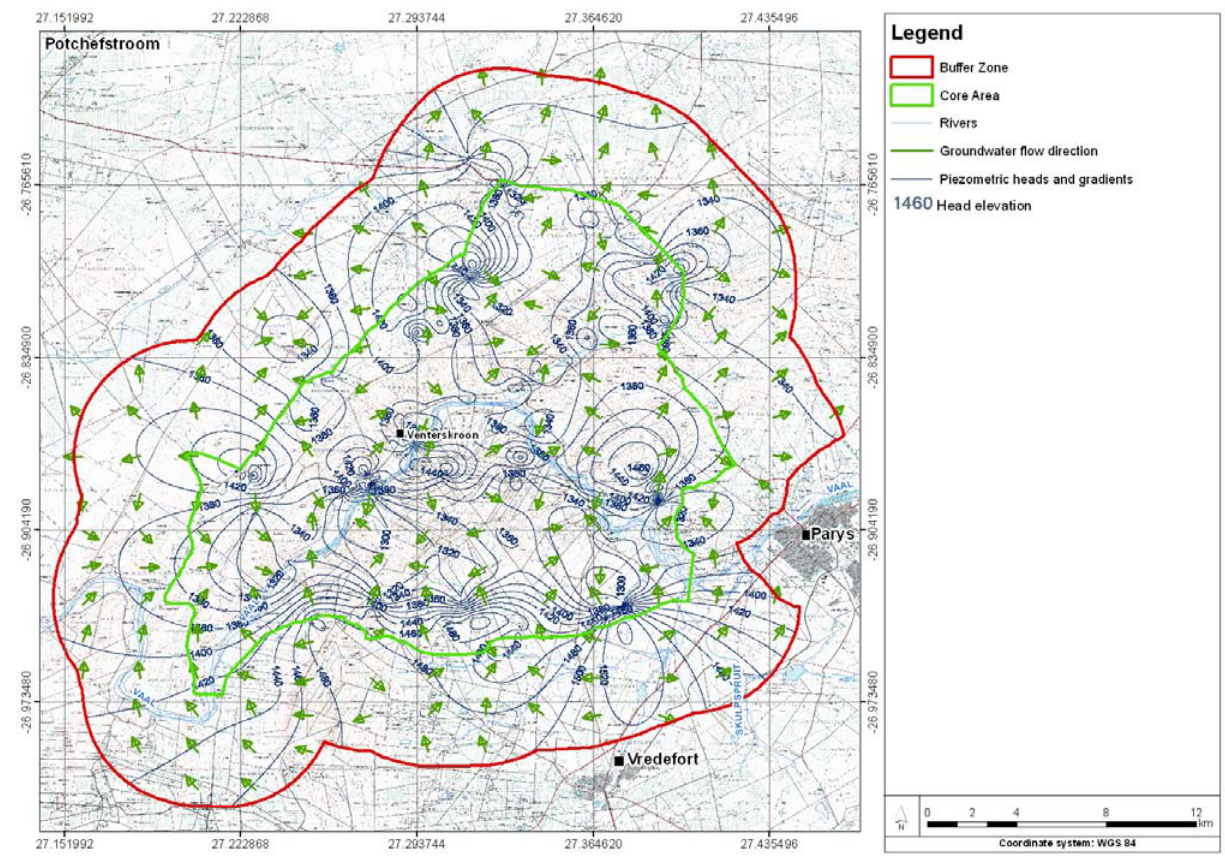
Figure 8. Groundwater flow directions in the